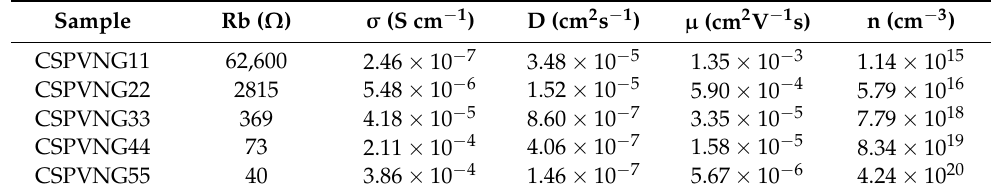
Table 4. Transport parameters of the plasticized PBE